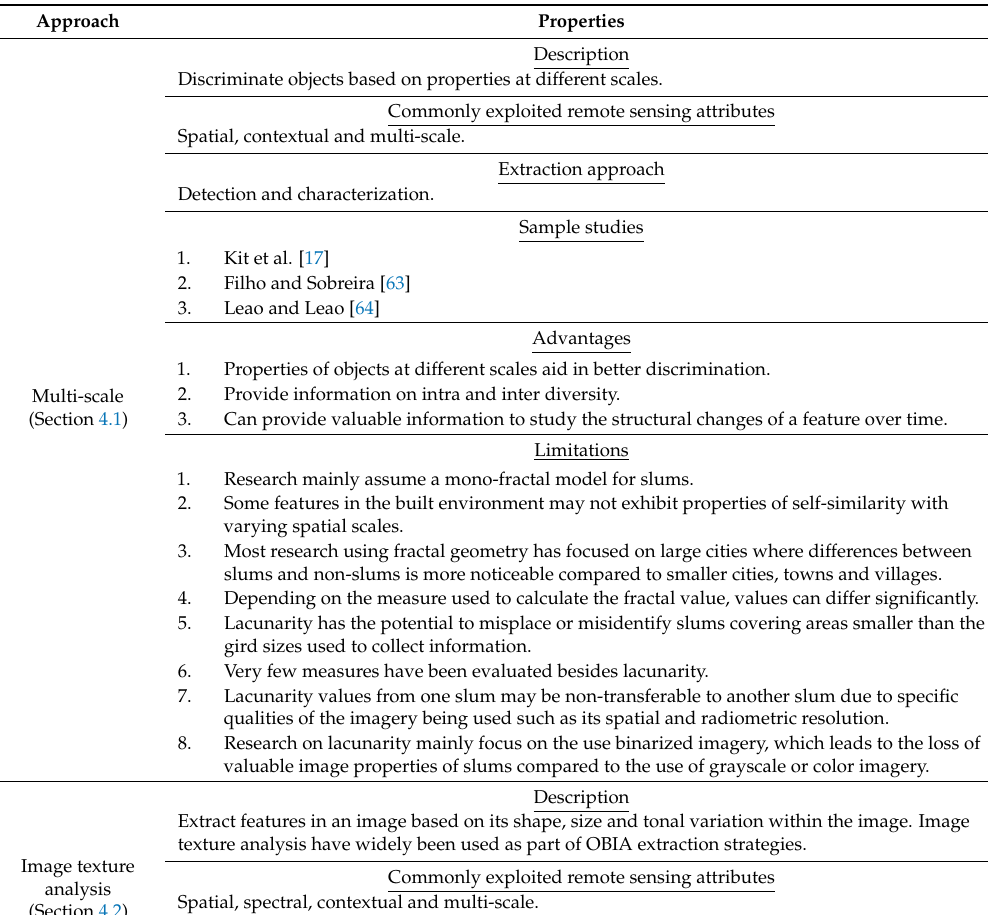
Table 1. Remote sensing approaches using H/VH-R imagery for identifying and mapping slums.